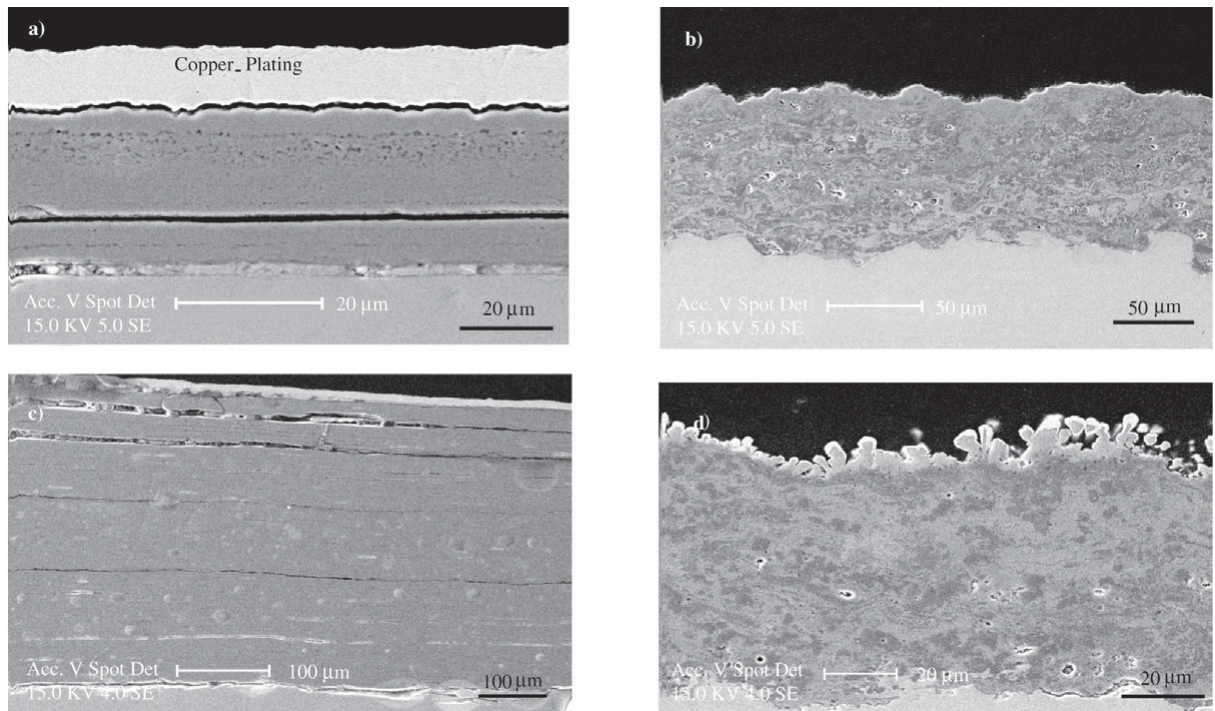
Figure 7 . Cross-sections of Ti with and without composite coating: a) 700 °C, 400 h; Ti, b) 700 °C, 400 h, coated Ti; c) 800 °C, 240 h, Ti; d) 800 °C, 240 h, coated